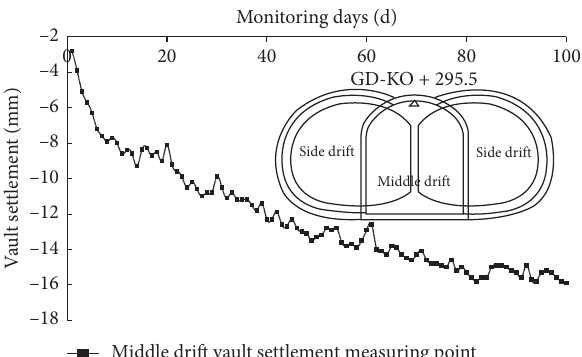
Figure 21: The settlement of the vault in the middle guide hole changes with the monitoring